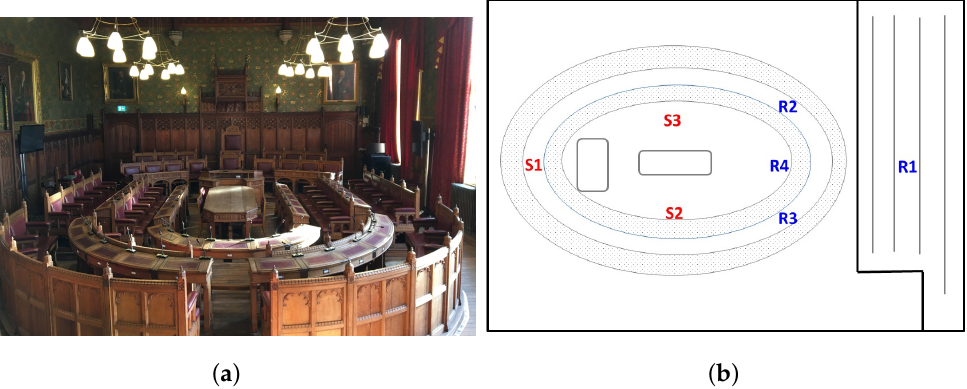
Figure 19. ( a ) Photograph of the York Guildhall Council Chamber (2023) and ( b ) floor plan of the measured positions.